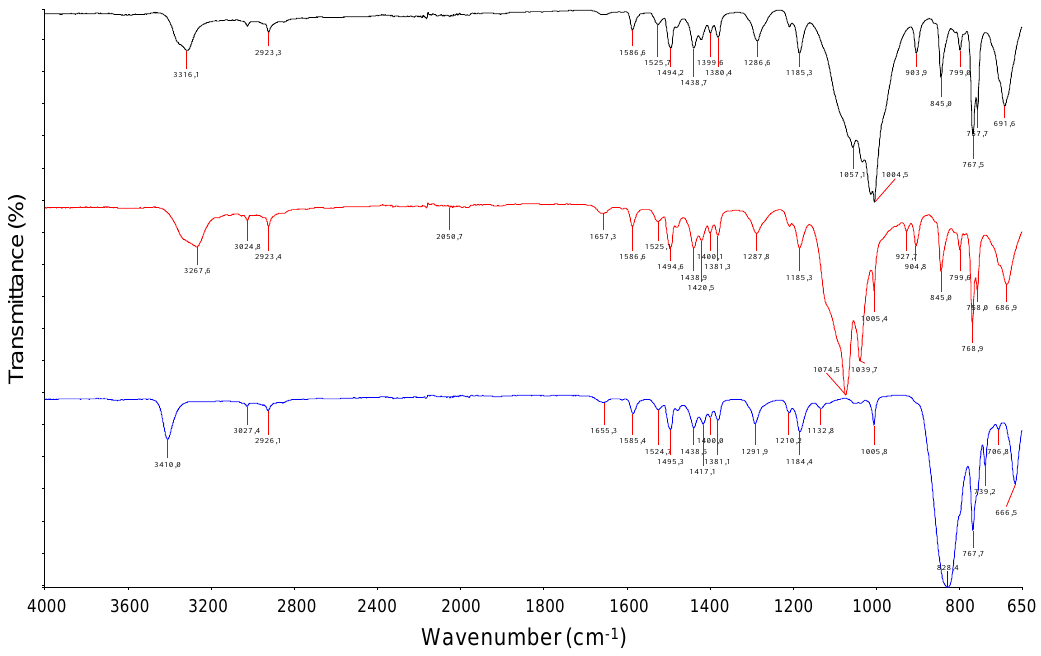
Figure 3. FTIR spectra of silver(I) CPs 4 (black), 5 (red), and 6 Figure 3 . FTIR spectra of silver(I) CPs 4 (black), 5 (red), and 6 (blue).